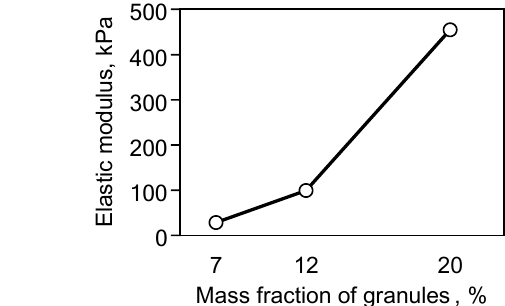
Figure 4. Bone regeneration capacity in the critical-size calvarial bone defect area of rats after implantation of the material based on the reacetylated chitosan/ β -glycerophosphate hydrogel and 12 wt% PLA granules containing 0, 10, and 50 μ g/mL of BMP-2. H&E and Masson’s trichrome staining after 28 days. PLA—highly porous polylactide granules, NB—newly formed bone, BV—blood vessel, GC—foreign-body giant cell, CT—connective tissue, IM—implanted material, and BM— bone marrow.